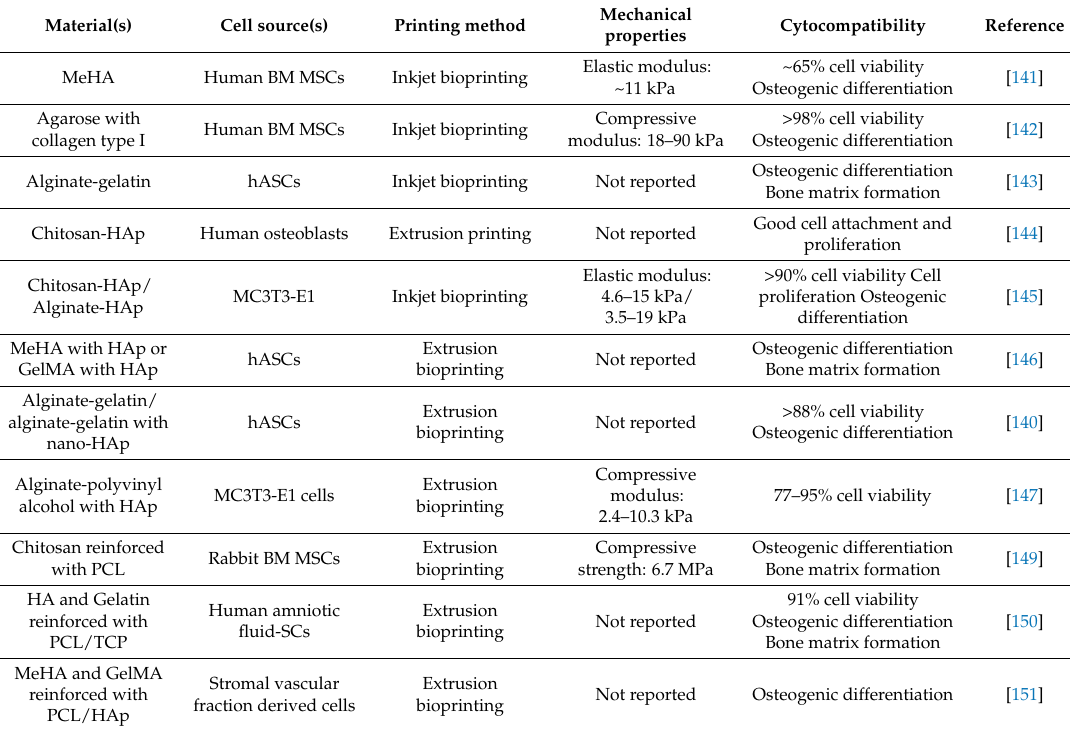
Table 3. Overview of publications on 3D printing of hydrogels for bone tissue